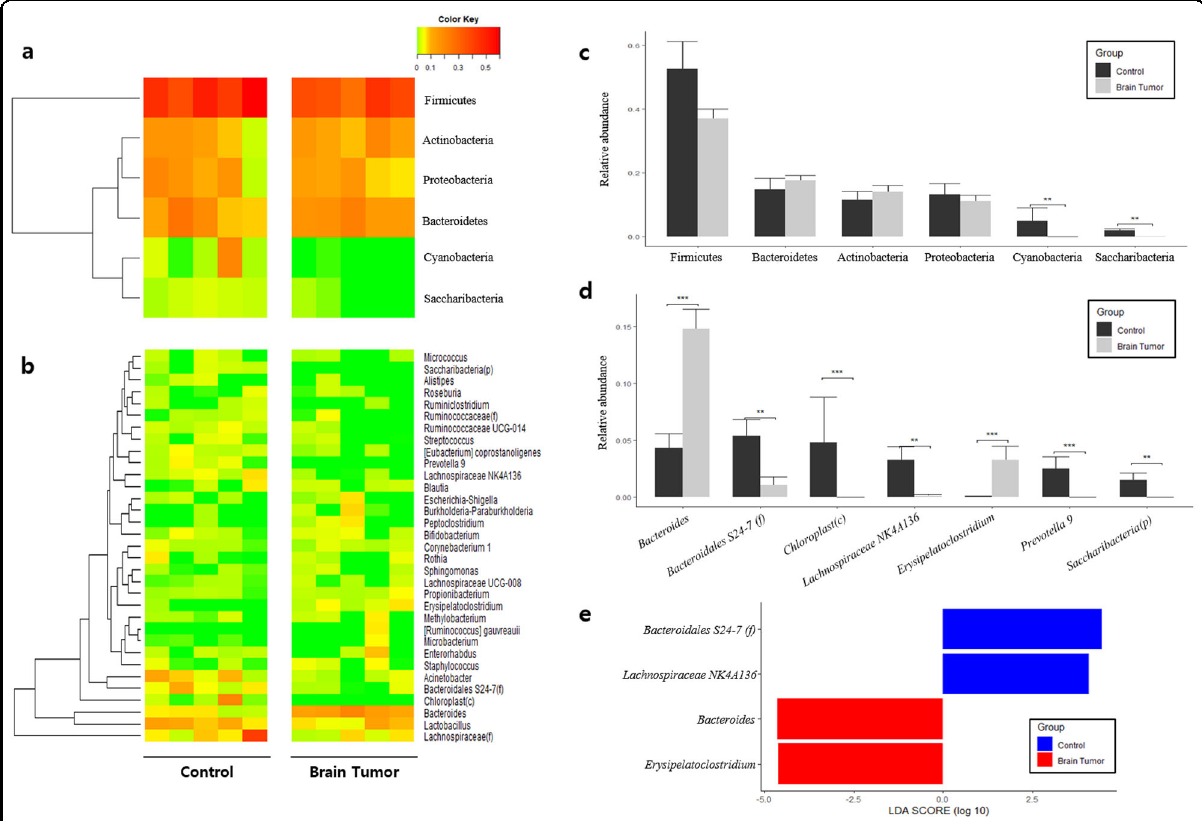
Fig. 5 Differences in EV microbiome abundance between healthy control (HC) subjects and brain tumor (BT) patients in brain tissue at the phylum and genus levels. Heatmap of core microbial EV taxa in brain tissue at the a phylum and b genus levels. Major bacterial EVs of both clinical groups and signi fi cant differences between groups were assessed using a t -test at the c phylum and d genus levels. e Signi fi cantly different bacterial EV biomarkers selected via LEfSe at the genus